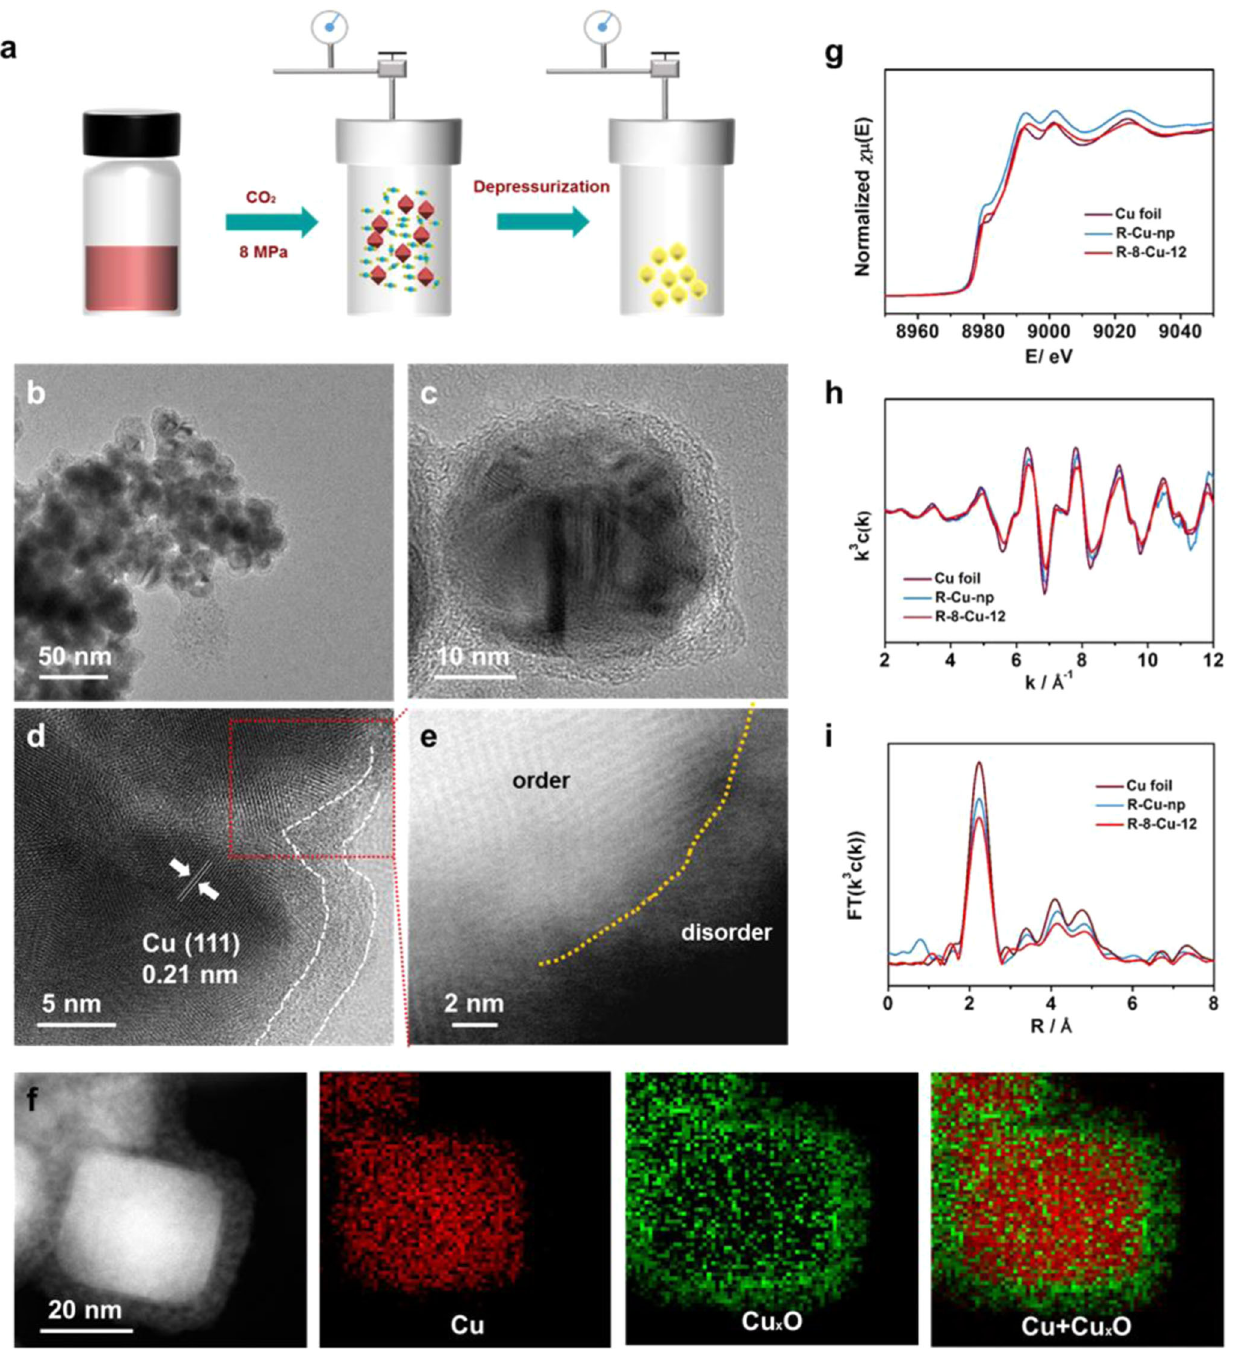
Fig. 1 | Structural characterization of the catalysts. a The schematic of the pre- parationofamorphouscatalysts. b , c TheTEMimagesof8-Cu-12. d HR-TEMimages of the 8-Cu-12. e HAADF-STEM images of the 8-Cu-12. f EELS maps of Cu and Cu x O